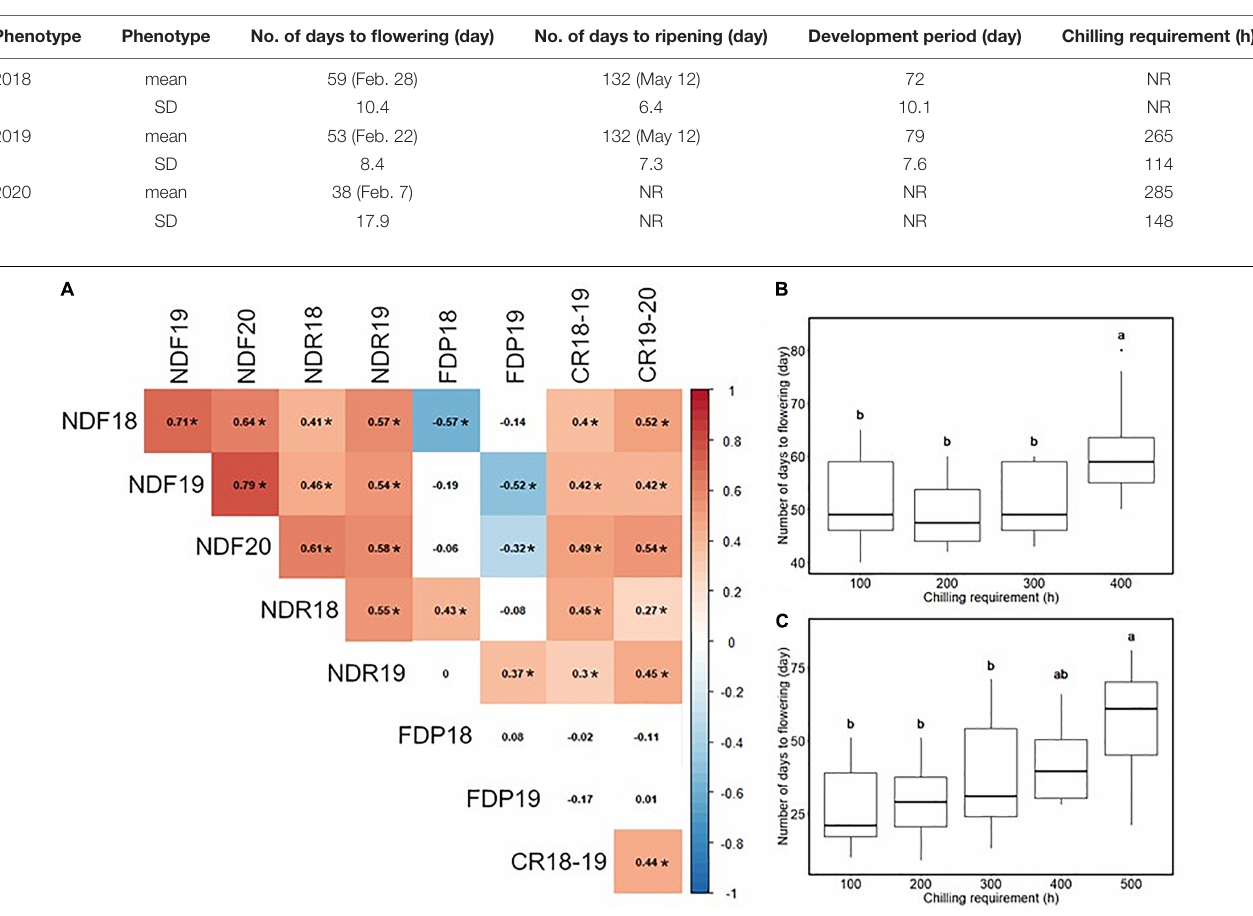
TABLE 1 | Phenology-related traits of southern highbush blueberry (SHB) collection.